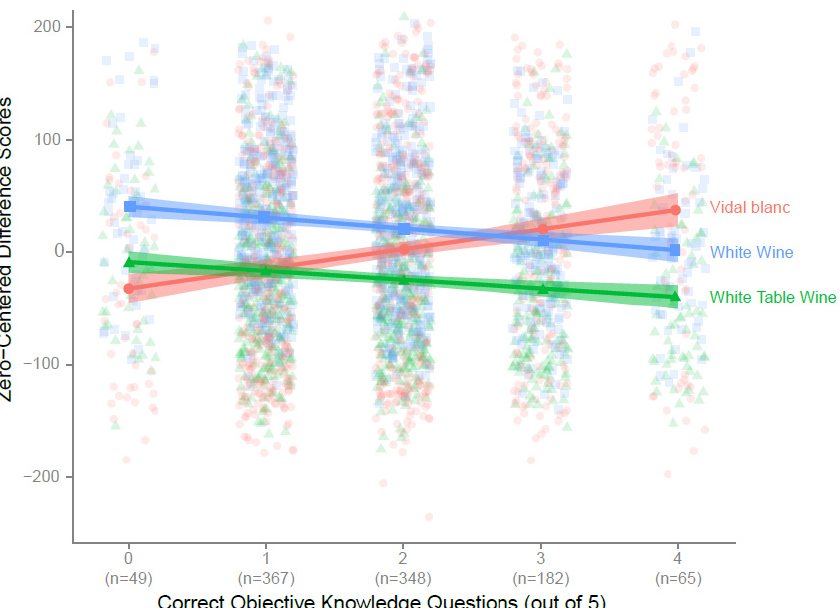
Figure 2. Participants’ zero-centered difference scores over correct responses to the objective knowledge questionnaire with linear regression lines for each wine tag (red circles—Vidal Blanc: 𝑦 = −31.9 + 17.4 ∗ 𝑥 , R 2 = 0.03; p = 3.34 × 10 − 8 ; blue squares—White Wine: 𝑦 = 40.5 − 9.66 ∗ 𝑥 , R 2 = 0.02; p = 1.80 × 10 − 5 ; green triangles—White Table Wine: 𝑦 = −8.54 − 7.77 ∗ 𝑥 , R 2 = 0.01; p = 0.0007).